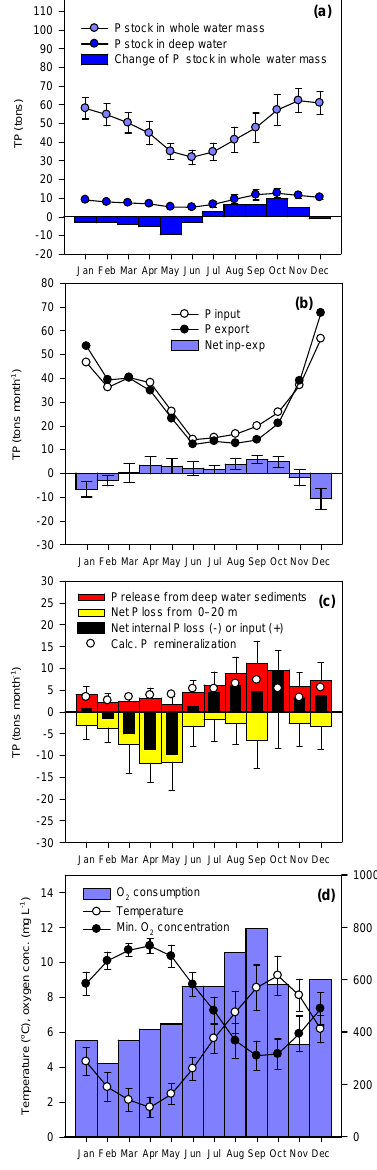
Figure 7. Monthly means and changes for 1996–2015 (2011 ex- cluded) in (a) total phosphorus (TP) stock and change in the whole water mass and stock in the deep water, (b) TP input and export with the boundary model, (c) net TP release in deep water ( > 20m) and net TP losses in the upper water layers (0–20m) and calculated P remineralization (from modelled O 2 consumption), with the mean model, and (d) deep-water temperature, O 2 consumption, and mini- mum O 2 concentration. Error bars show standard deviation. Graphs for other time periods are shown in Supplement Fig.